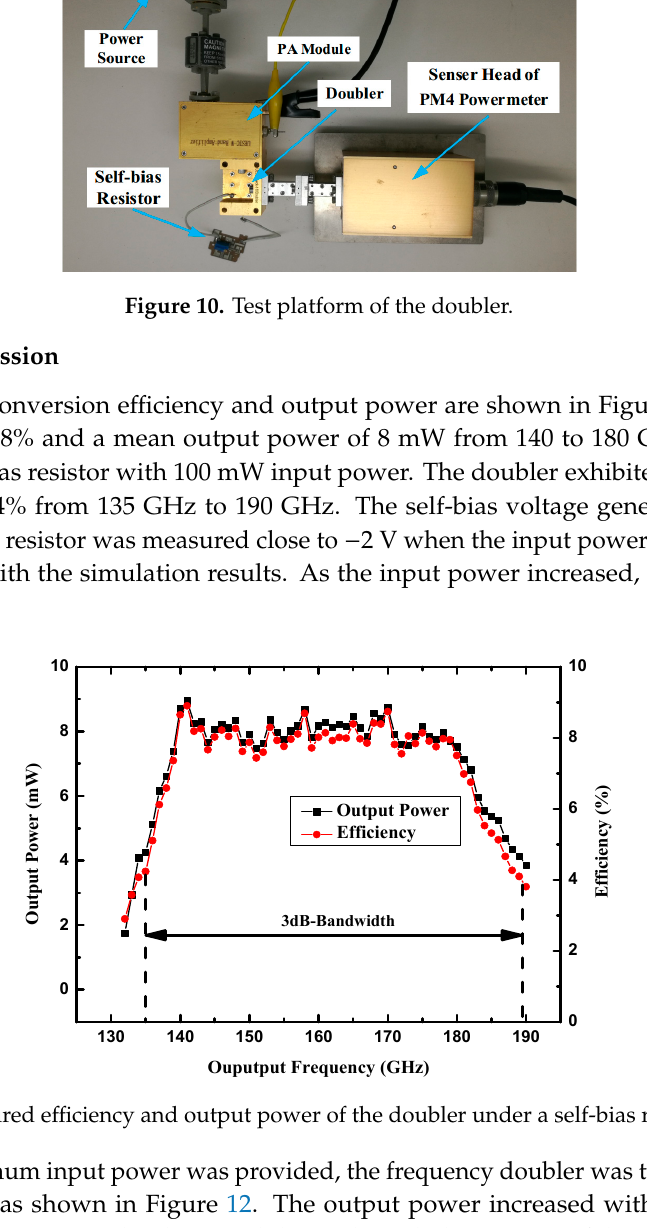
Figure 9. The image of the 135–190 GHz doubler imbedded in the split-waveguide block.